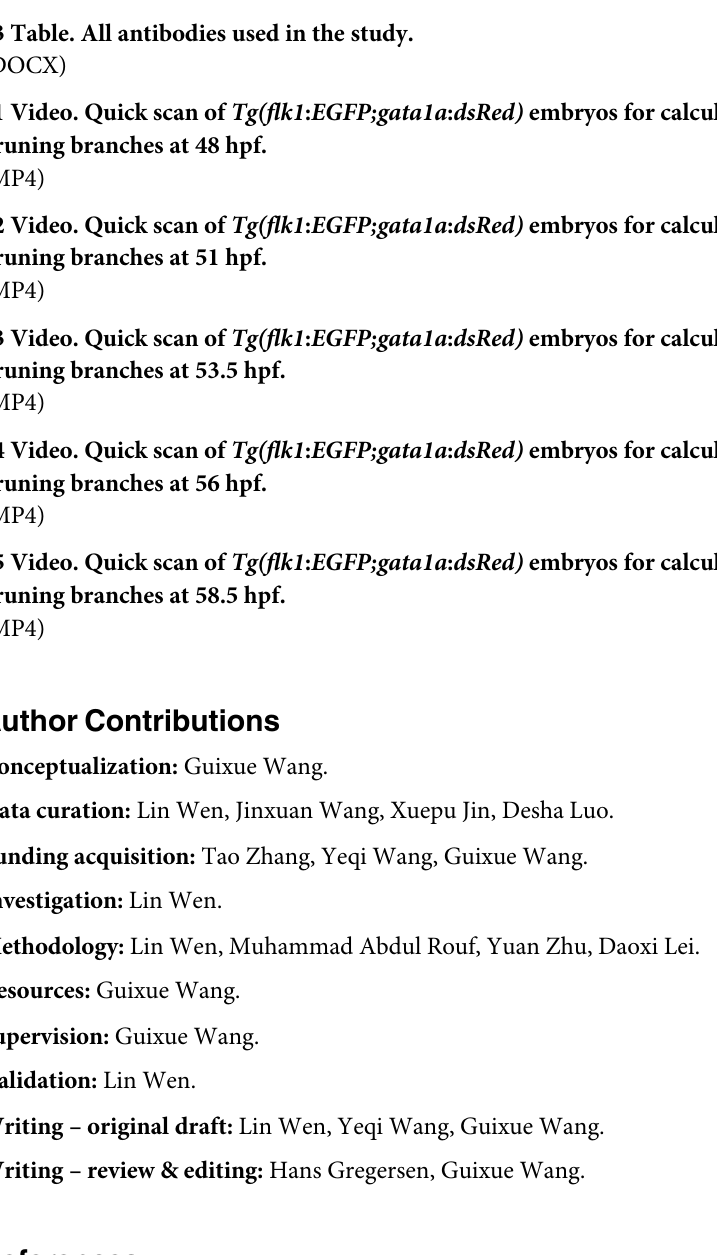
S1 Table. MO sequences. S2 Table. Primers for the klf6a or tagln2 mutant, KI(klf6a— HA -P2A-gal4) genotyping, WISH, ChIP-PCR, and RT-PCR. S3 Table. All antibodies used in the